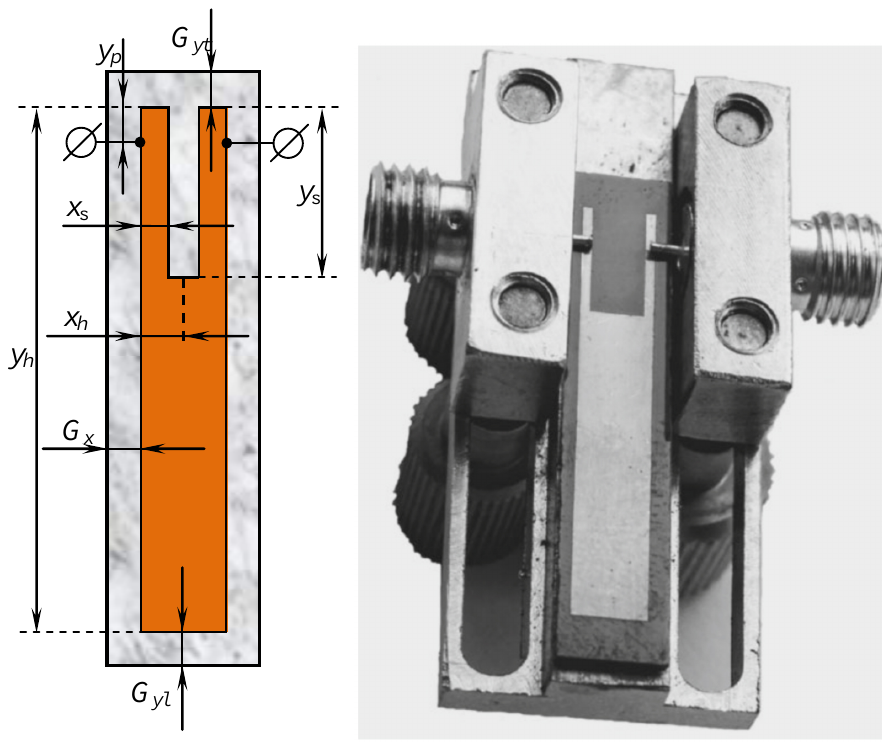
Figure 1. U-shaped (slot-split rectangular) 3-mode resonator: layout and manufactured device.